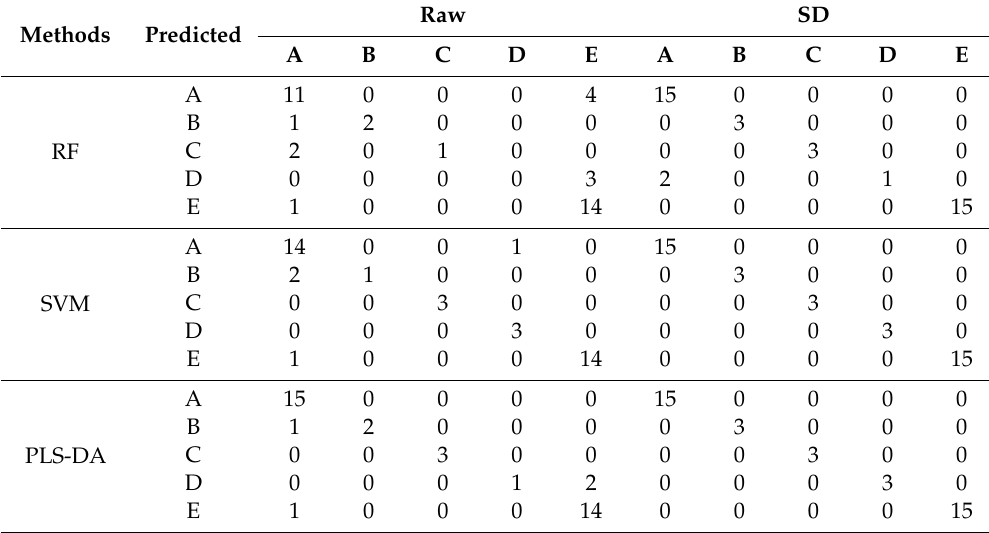
Table 3. Summary of the classification of Lingzhi by di ff erent models and spectra pretreatment using ATR-FTIR spectra.